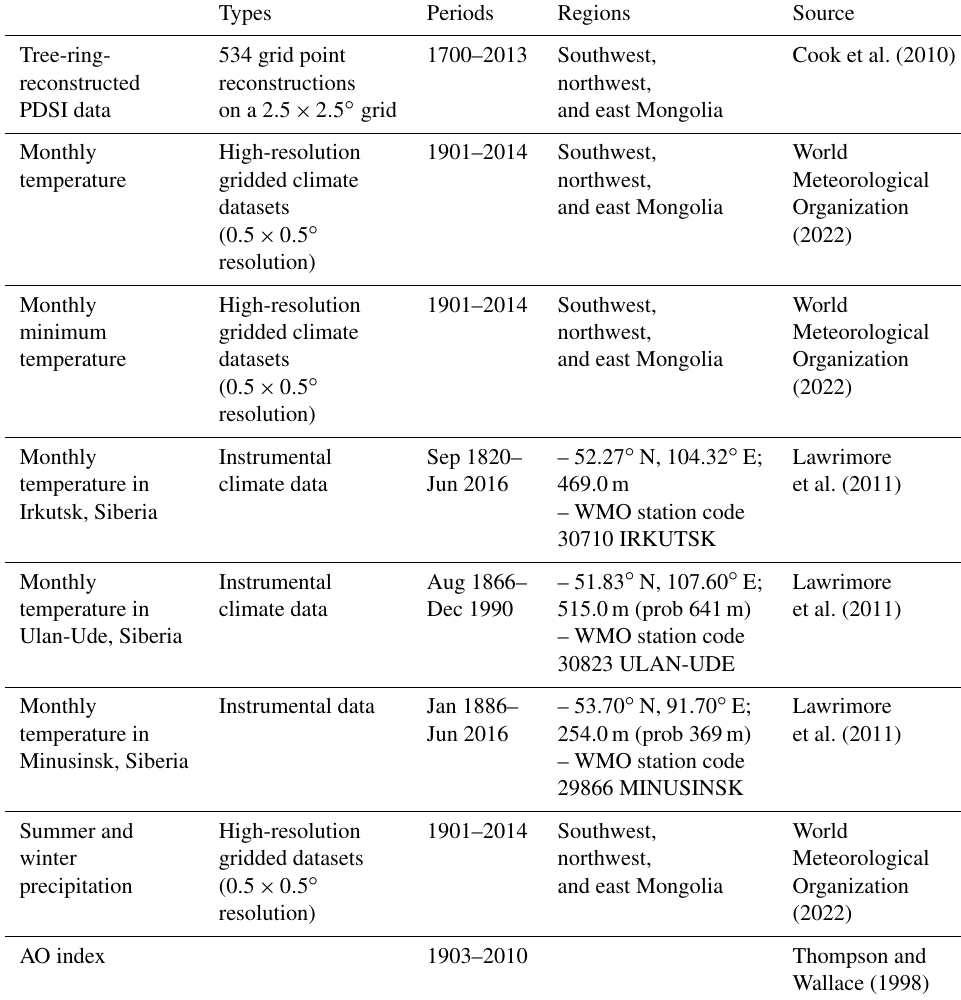
Table 2. Data analyzed in this study. WMO denotes World Meteorological